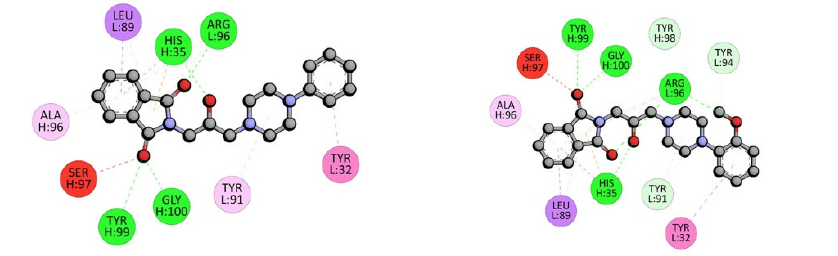
Figure 11. Docked pose and interactions of compound F4 with GG.